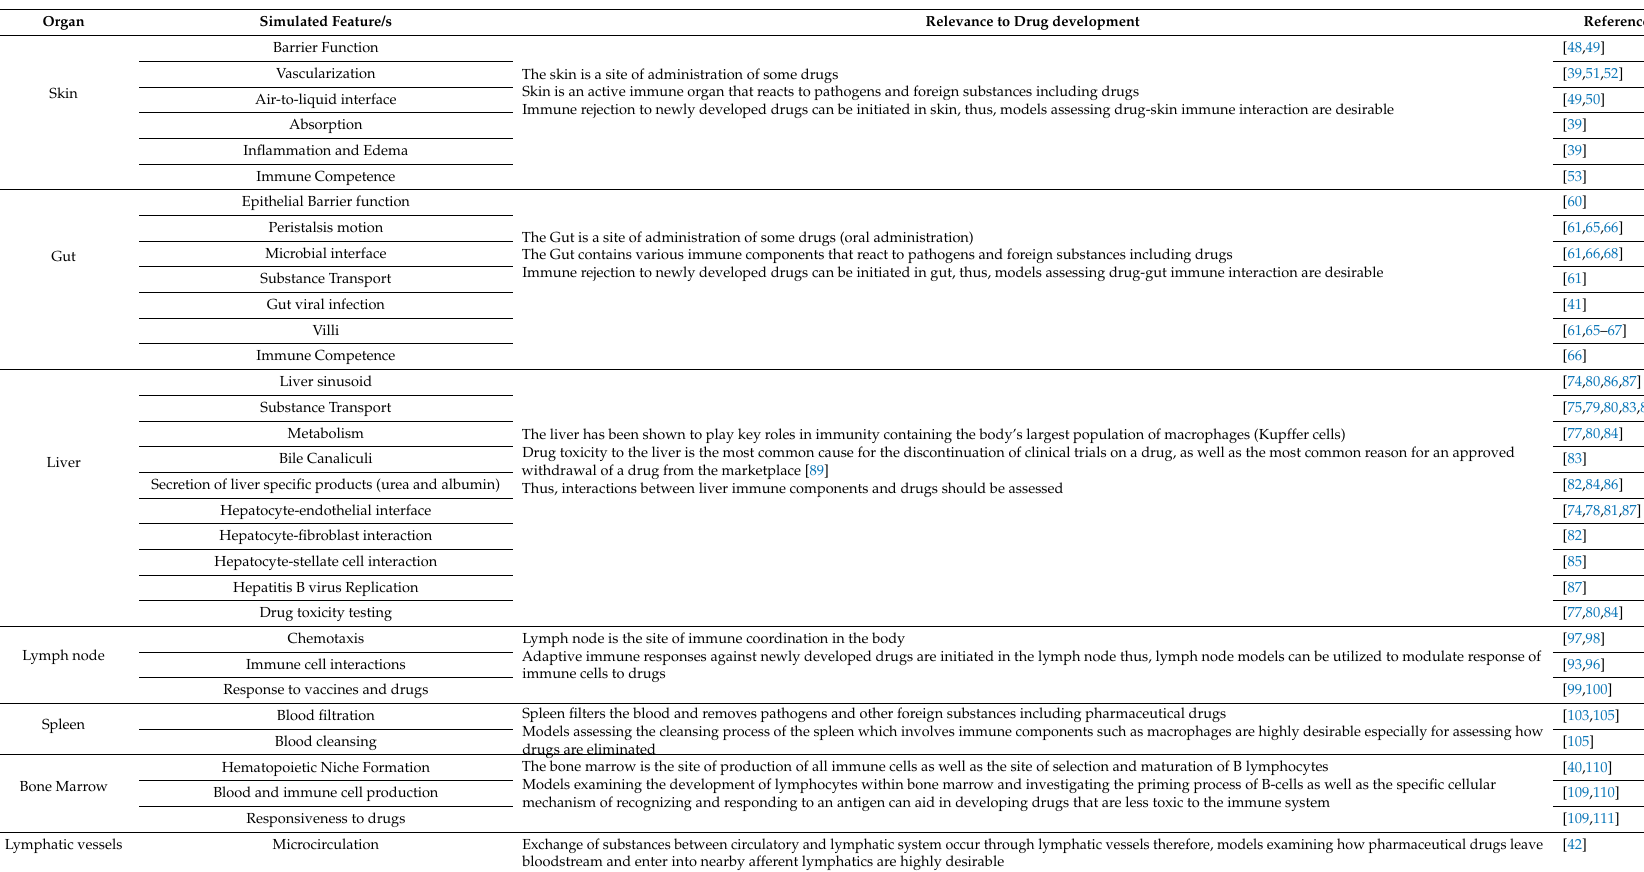
Table 1. Summary of available